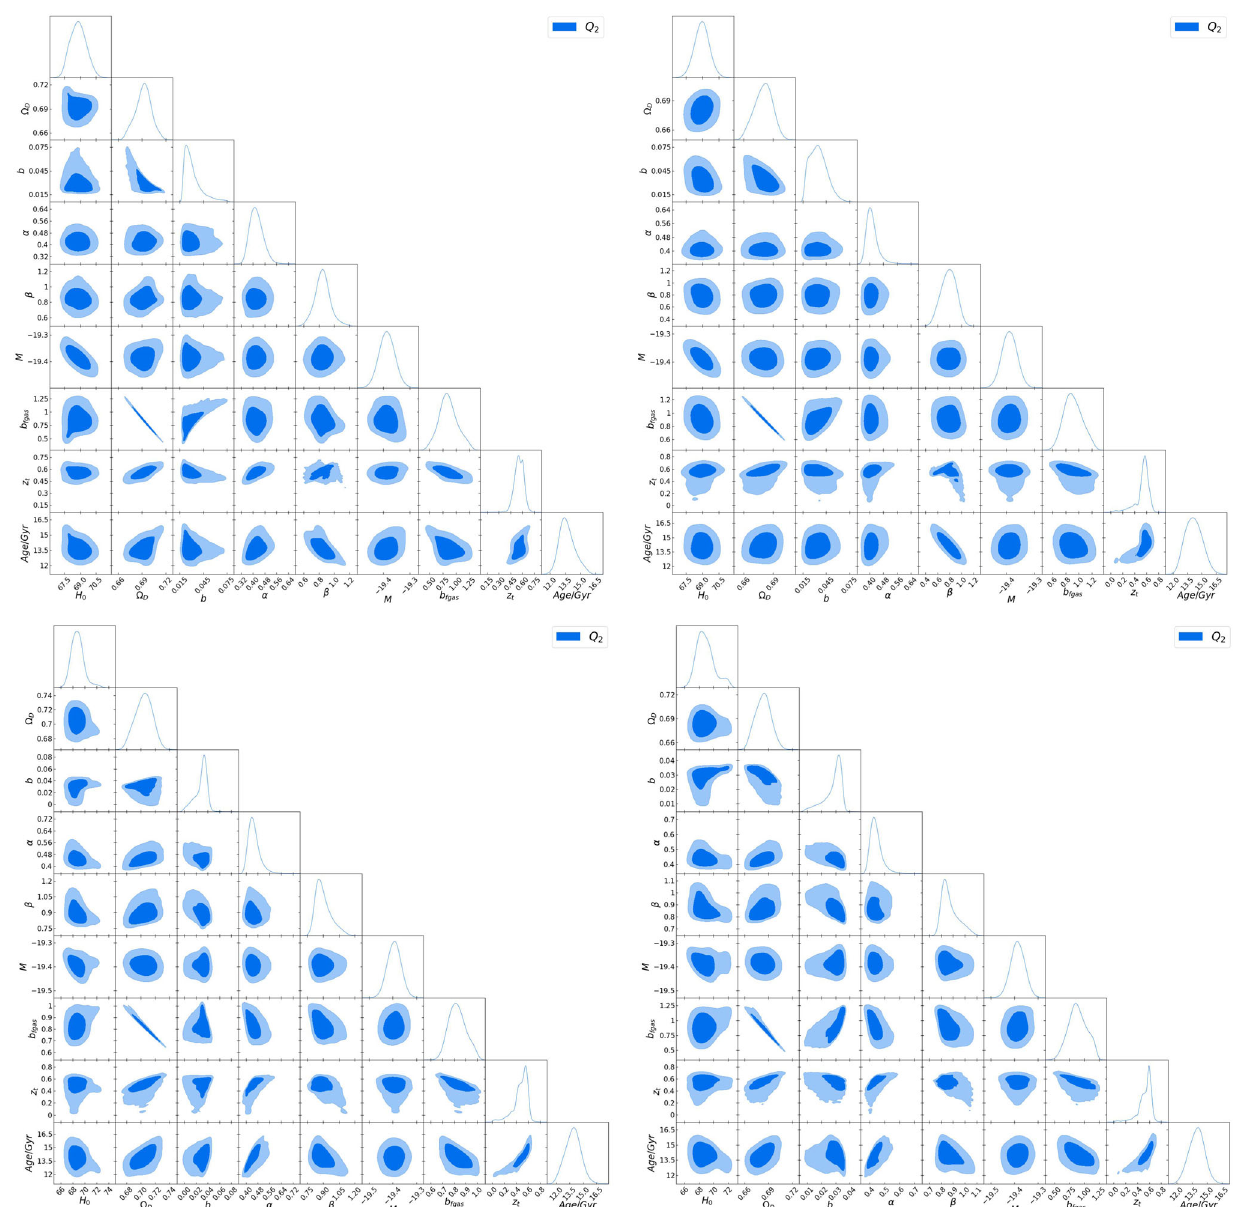
Fig. 10 The contour maps of the EHRDE (see Eqs. (21) and (22)) with fourtypesofnon-linearinteraction Q 4 , Q 5 , Q 6 and Q 7 listedinTable1. In this figure H 0 is the Hubble parameter, (cid:5) D is the dark energy density, α and β are the dimensionless parameters, b is the coupling constant, M